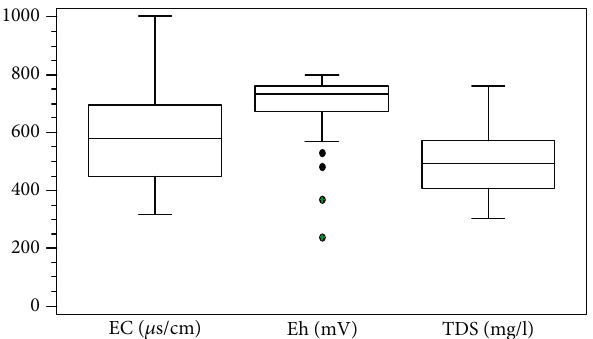
Figure 2: Box-and-whisker plots of physico-chemical